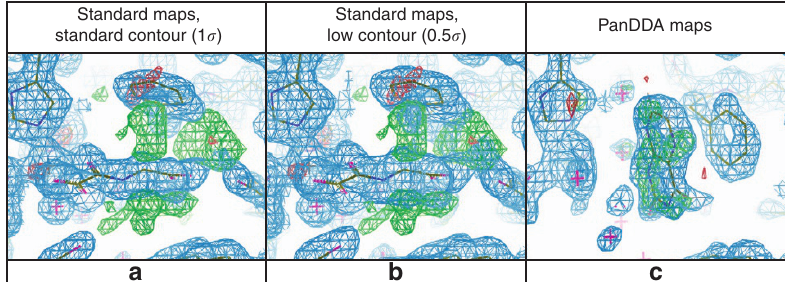
Figure 3 | PanDDA maps clearly show detail obscured by conventional maps. JMJD2D fragment screening data set x401 at 1.48Å. ( a , b ) Conventional maps (2mF o –DF c , blue, contour as indicated; mF o –DF c , green/red, ± 3 s ) are dominated by the NOG co-factor analogue bound in the majority fraction of the crystal, whereas ( c ) the event map (blue, 2 s , BDC ¼ 0.9) and the Z -map (green/red, ± 4) unambiguously reveal both ligand and associated changes in protein conformations.